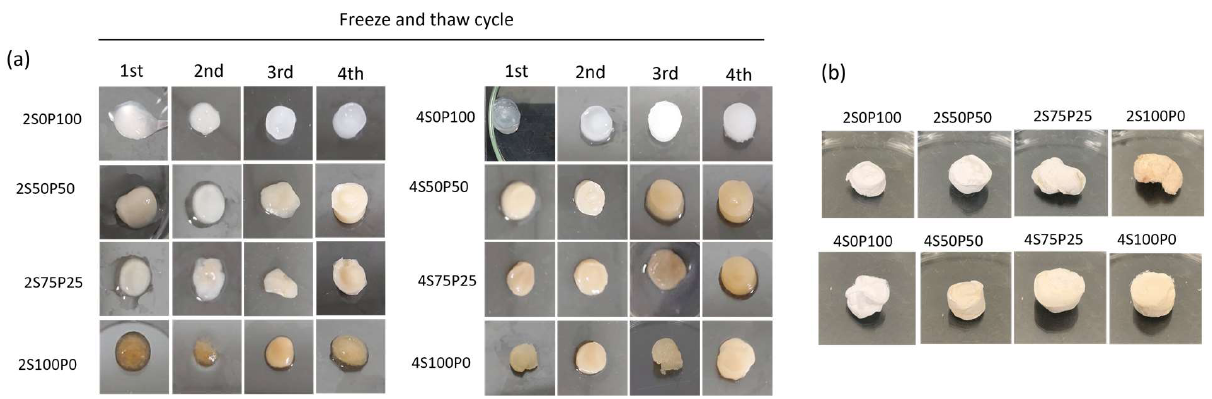
Figure 2. ( a ) Composition and freeze–thawing cycle effect on the physical appearance of the hydrogel ( b ) freeze-dried hydrogel after four cycles of freeze–thawing. S and P denote sericin and PVA with various volume ratio.